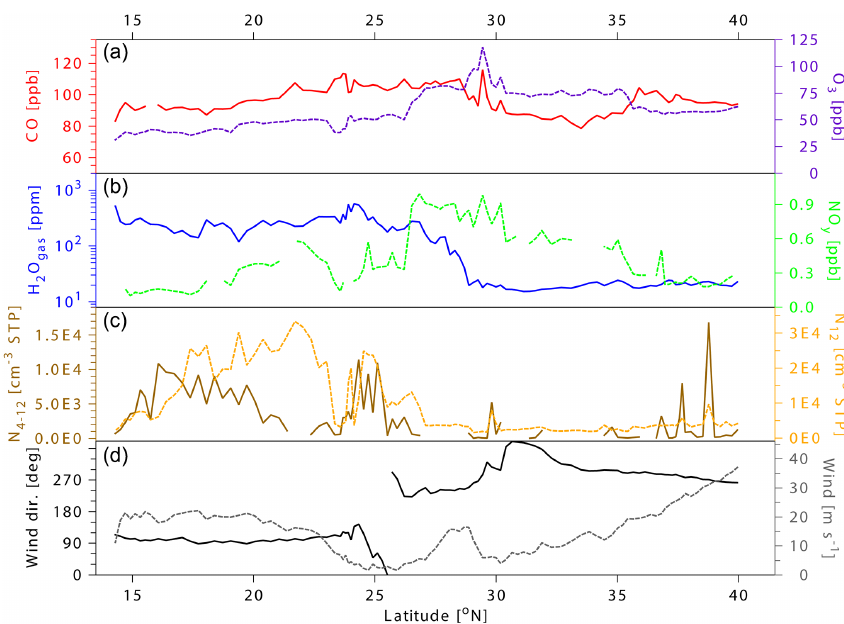
Figure 5. Latitudinal profiles of trace gases and meteorological parameters during the second flight in August from Frankfurt to Chennai on 14 August 2008. In addition to colour coding of axes, scales for parameters represented by solid lines are on the left and scales for parameters represented by dashed lines are on the right. Aerosol particle number concentrations are given at STP (273.15K, 1013.25hPa). Note that all data are shown versus geographical latitude and that the water vapour shown in blue in (b) is on a logarithmic scale (see also Figs. S9–S21 in the